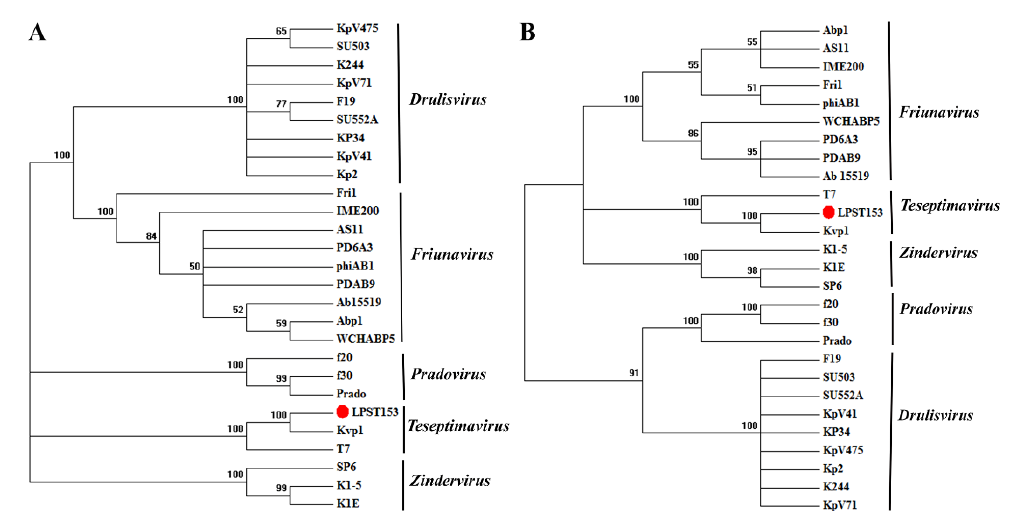
Figure 4. Phylogenetic analysis of phages in different genus of Autographivirinae subfamily based on their terminase large subunit. ( A ) and major capsid proteins. ( B ). Phylogenetic trees were constructed using the neighbor-joining method with 1000 bootstrap replications.